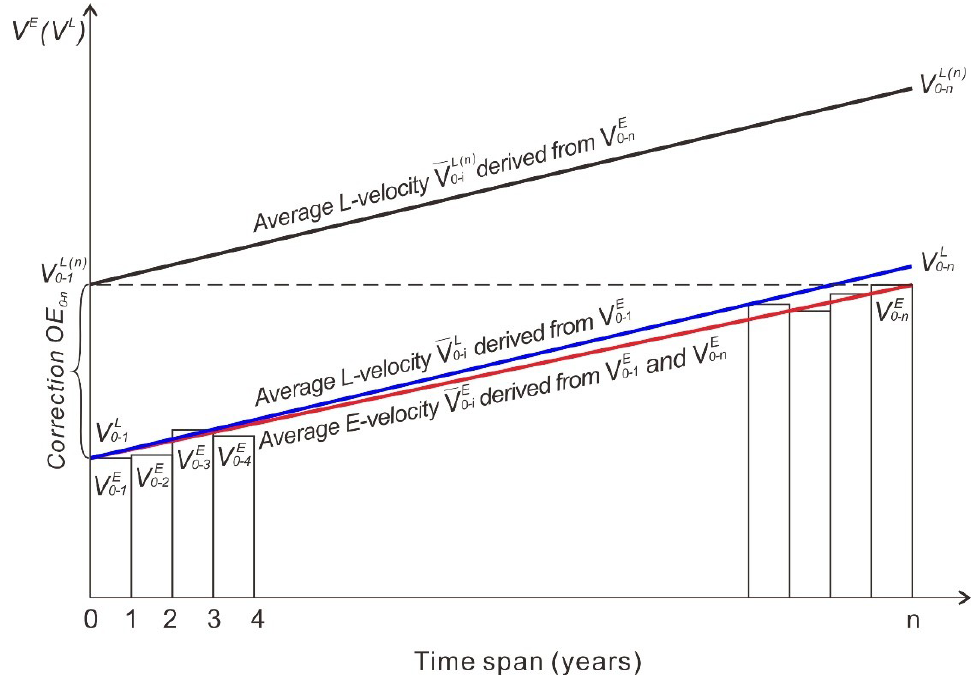
Figure 2. Derivation of equation for overestimation correction using L velocity. Eulerian velocities V E bars. The red line is the average Eulerian velocity V and V L derived from V E . The black line is the average Lagrangian velocity V 0 − 1 0 − n